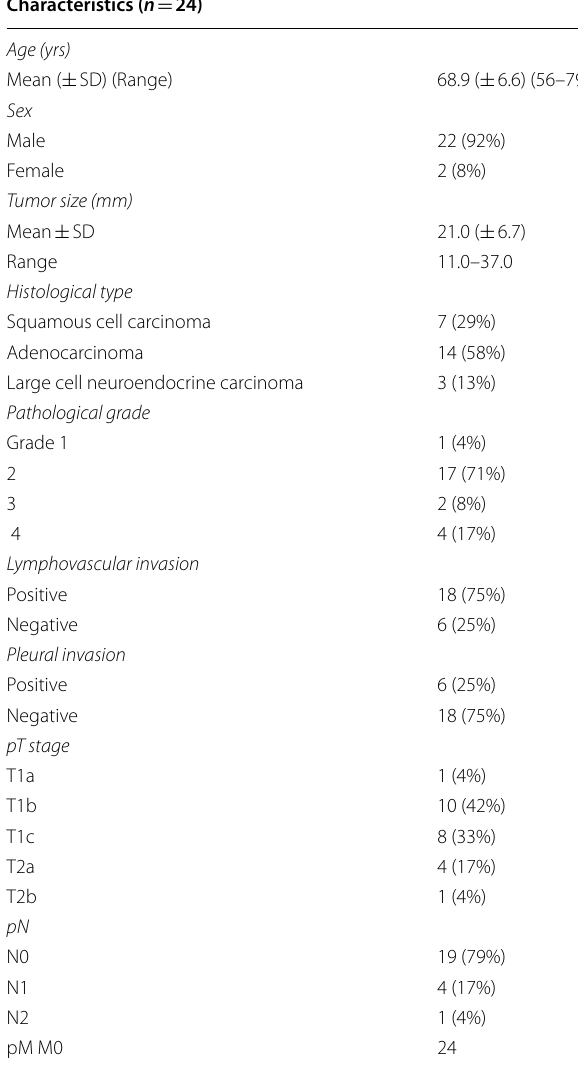
Table 1 Patient and tumor characteristics